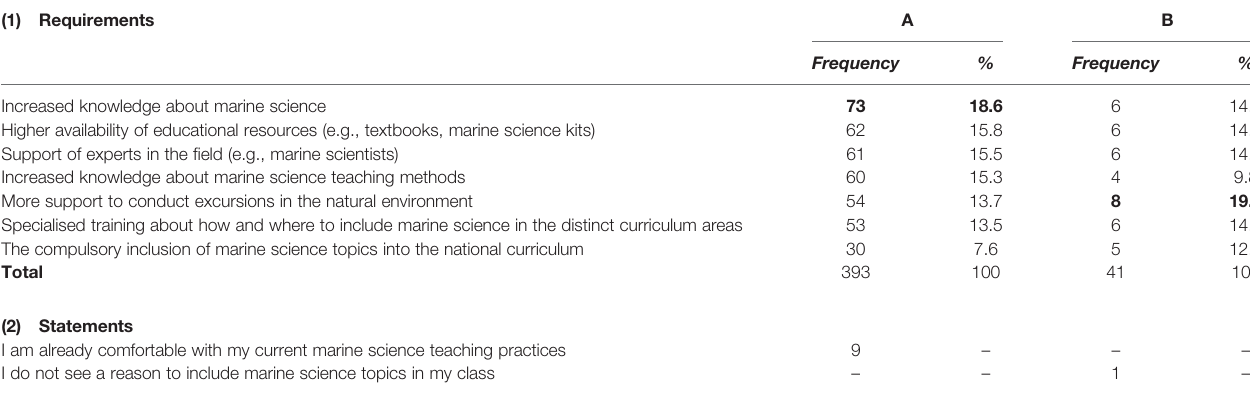
TABLE 3 | (1) Frequency and percentage of each of the requirements selected by teachers that would lead those already incorporating marine science in their classes them to improve (column A) or those yet to incorporate marine science in their classes to include (column B) marine science topics in their lesson plans.